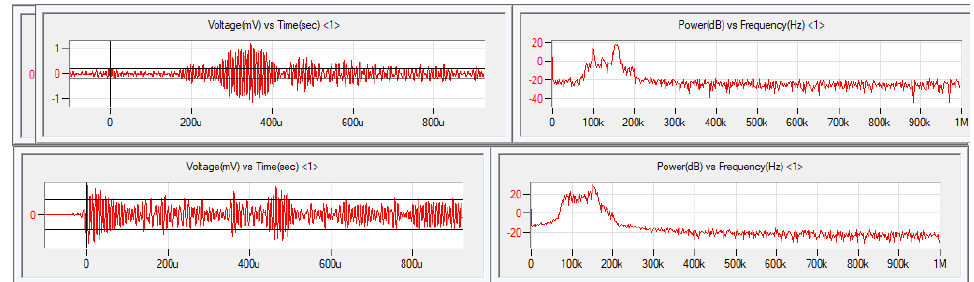
Figure 1. Response of AE sensor with ( up ) and without ( bottom )